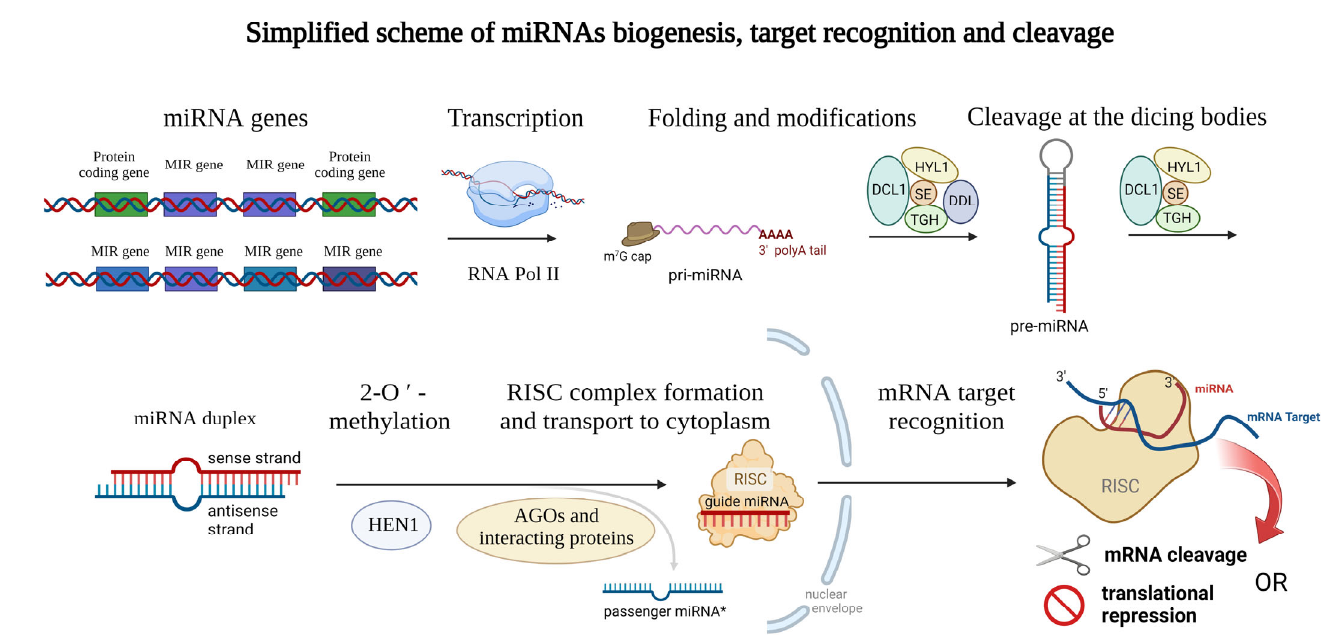
Figure 1. Schematic representation of the miRNAs biogenesis. Genes encoding miRNAs are transcribed by RNA polymerase II and modified on their ends (m 7 G cap and polyA tail) and thus the primary microRNA (pri ‐ miRNA) arise. Then, the typical stem ‐ loop structure is formed by complementary base pairing and cleaved at the dicing bodies (consisting of several proteins including DCL1, HYL1, SE, TIGH, and DDL) resulting in miRNA duplex formation which can be later 2 ′‐ O ‐ methylated (ensured by the HEN1 protein). Guide miRNA is incorporated into the RISC consisting of several proteins, and transported into the cytoplasm, where mRNA target recognition and cleavage can take place while the passenger miRNA is released away. Proteins from the Argonaute family (AGOs) can modify the stability of the miRNAs and also affect the interaction with target mRNAs. This figure was created using BioRender (https://biorender.com/; accessed on 20 June 2022).